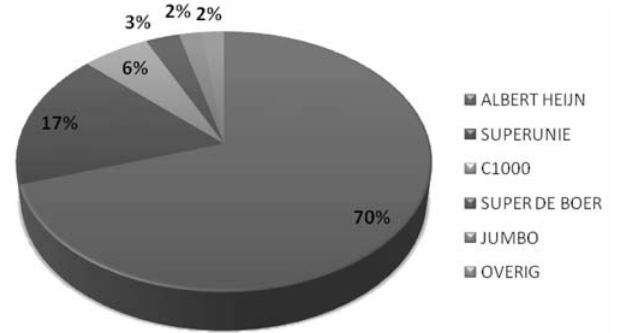
Figure 9. Supermarket Sales for pre-treated fresh fruit in 2010 (value) Source: PT / Nielsen